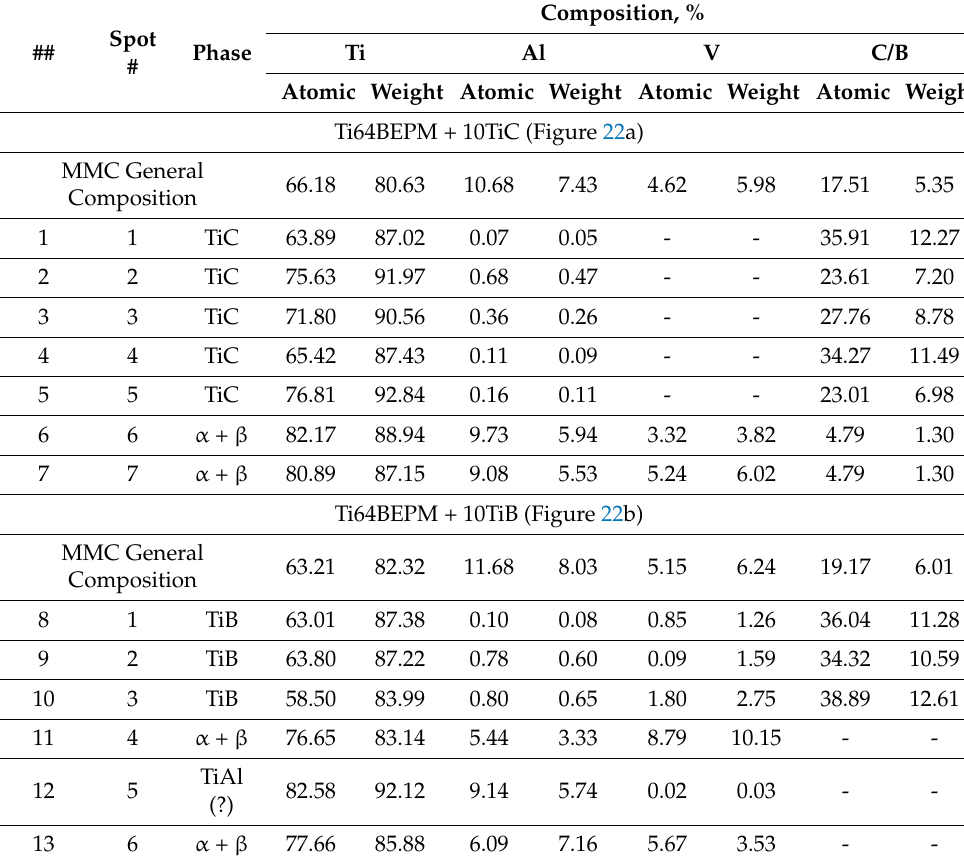
Table 4. Local chemical analysis of MMCs’ in spots shown in Figure